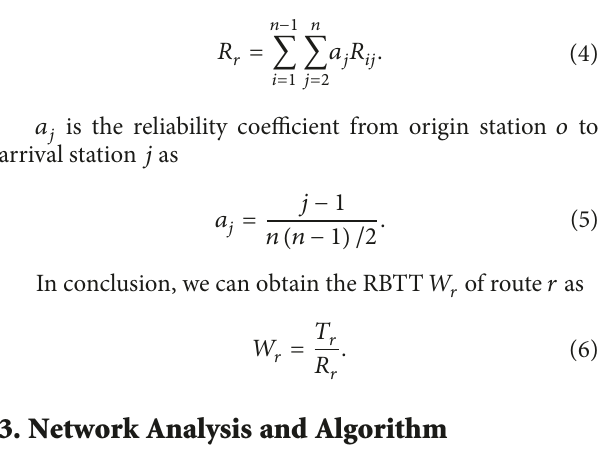
unable to meet passengers’ requirements. The smaller the TR value than 80%, the more likely the commuters to abandon these road sections. This is in line with the